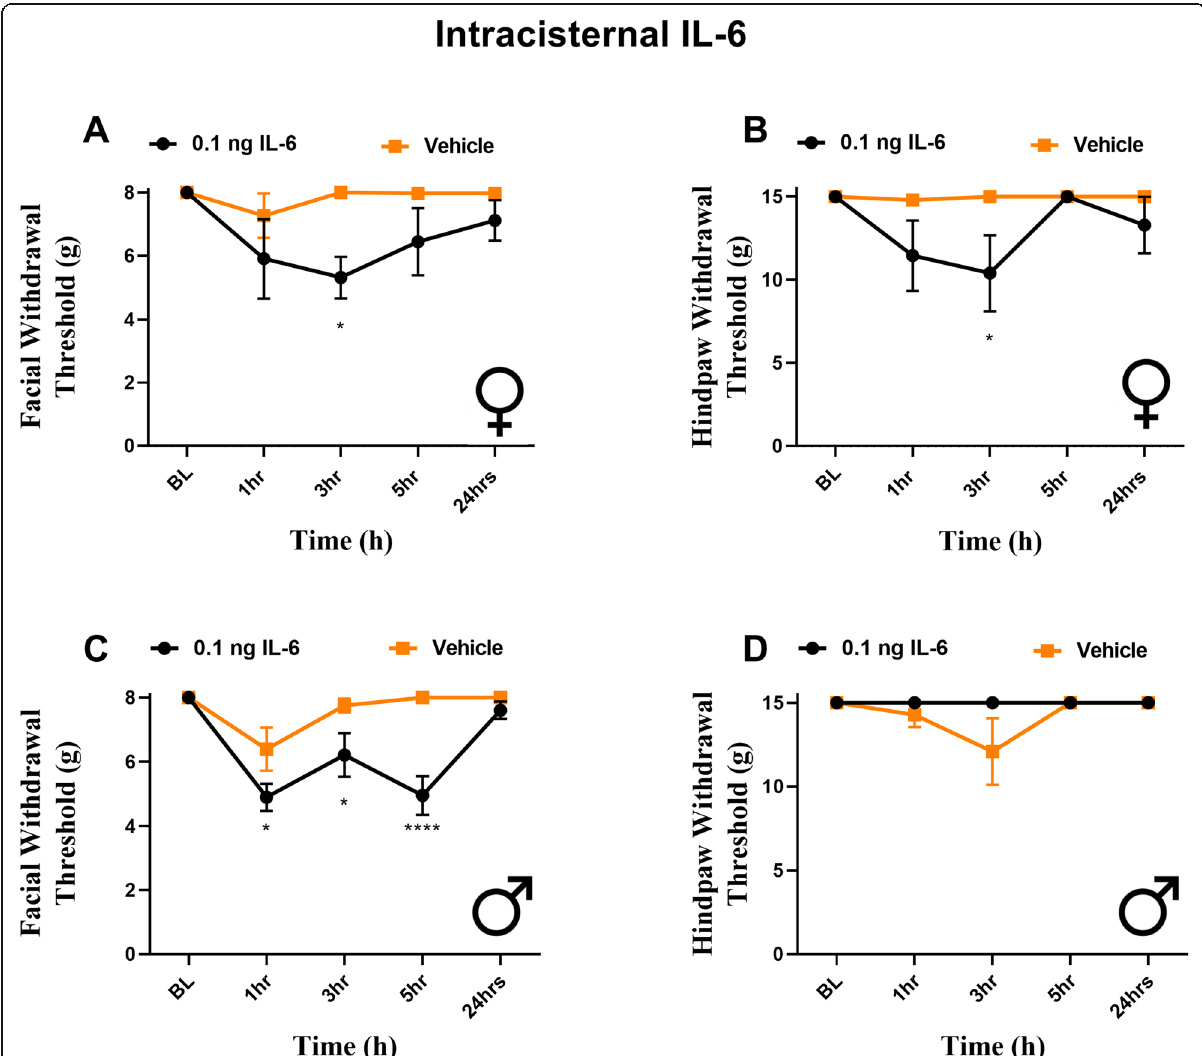
Fig. 6 Intracisternal IL-6 produces facial hypersensitivity in both sexes, but differential hindpaw responses. Female ( A , B ) and male ( C , D ) rats had baseline withdrawal thresholds of the face and hindpaw determined prior to intracisternal injection of IL-6 (4 females, 6 males) or vehicle (5 females, 7 males). Both females and males demonstrated significant effects of treatment on facial responses (F (1, 35) = 12.24, p = 0.0013) (F (1, 55) = 27.98, p < .0001); however, only females presented with hindpaw responses. (F (1, 35) = 9.640, p = 0.0038) * p < 0.05, **** p <